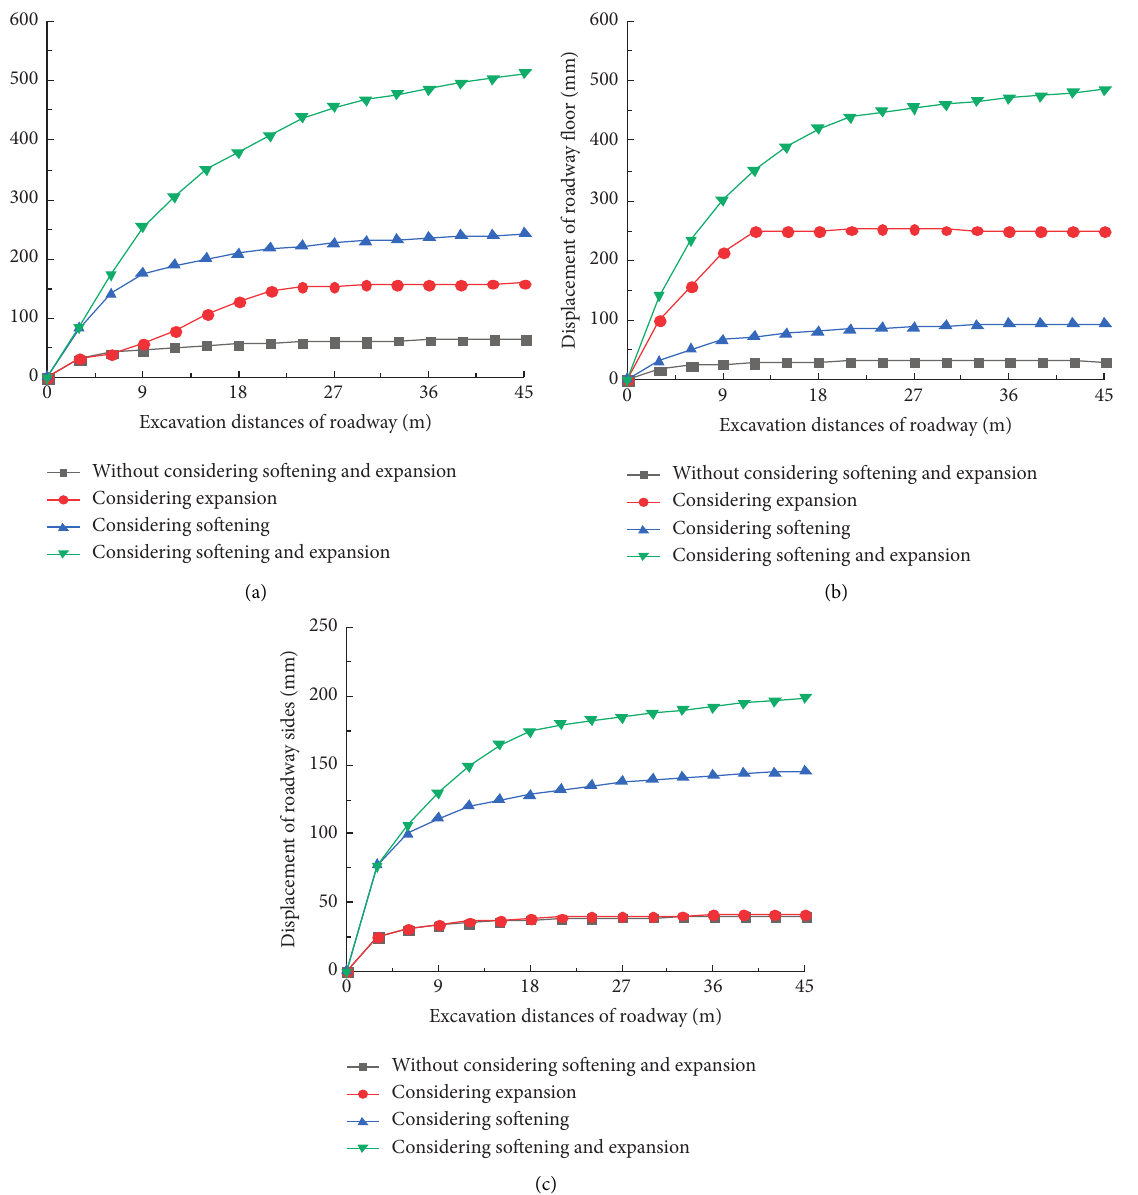
Figure 9: Change curves of surface displacement of weakly cemented soft rock in the roadway under different schemes. (a) Roadway roof. (b) Roadway floor. (c) Roadway